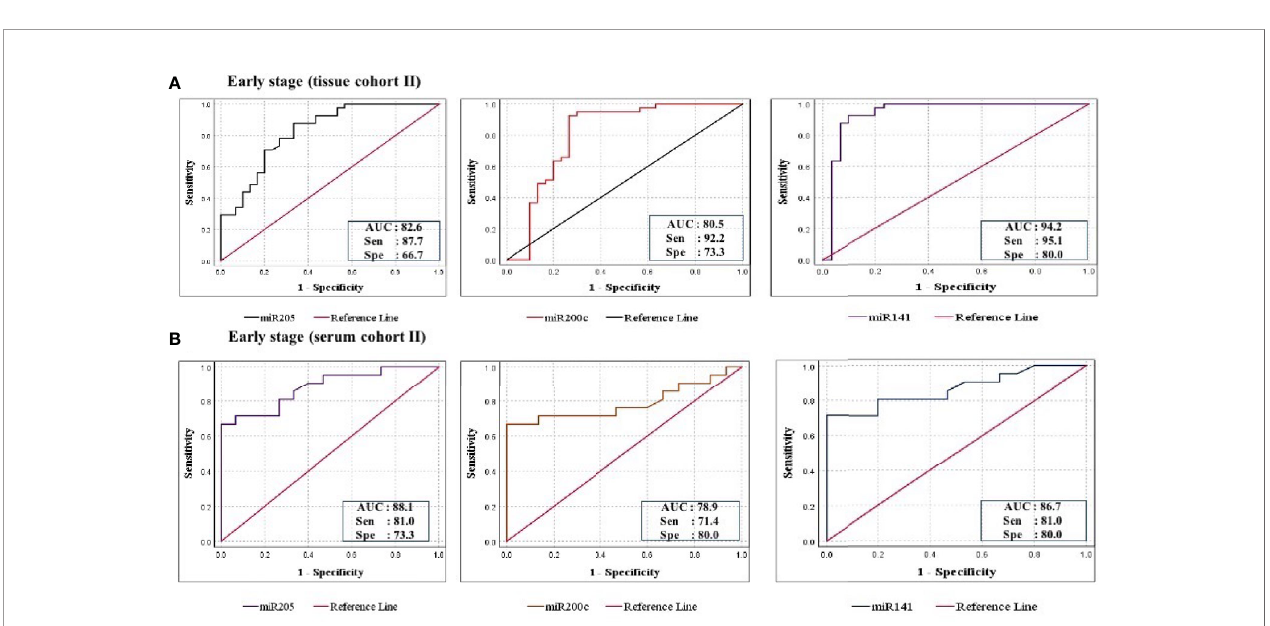
FIGURE 6 | ROC curve analysis incohort-IIof tissueand serum to evaluatethe abilityof eachmiRNA signatureto diagnose ovariancancer. (A) Intissue cohort-II ( n = 71), the combined measureofsensitivityandspeci fi cityof miR-205, miR-200c, andmiR-141 wasrepresentedbyAUCat95% CI, p -value= 82.6 (0.693 – 0.928, p < 0.0001), 80.5 (0.685 – 0.925, p < 0.0001), and94.2 (0.873 – 1.012, p < 0.0001),respectively. (B) Inserum cohort-II( n = 35), the AUC ofmiR-205, miR-200c, andmiR-141 at95% CI, p -value = 88.1(0.773 – 0.989, p < 0.0001), 78.9 (0.636 – 0.942, p <0.0001), and86.7(0.749 – 0.984, p <0.0001), respectively. AUC, areaunder thecurve; Sen, sensitivity; Sep, speci fi city.